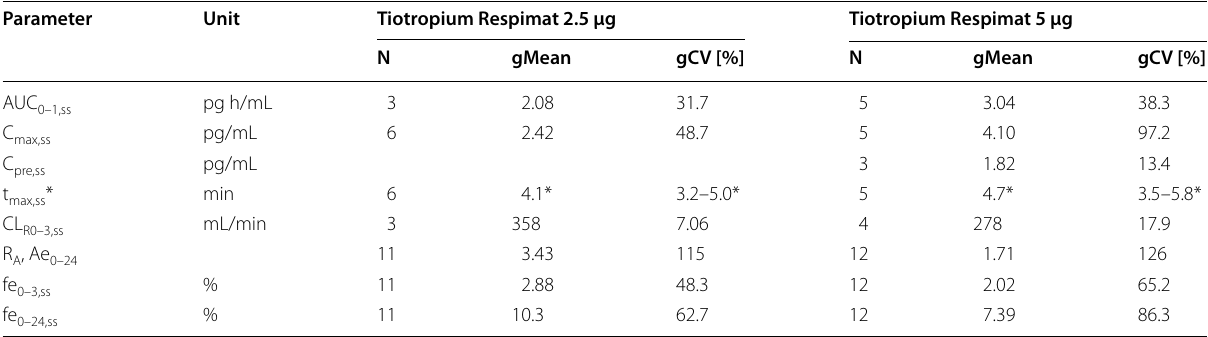
Table 1 PK parameters after multiple dosing of tiotropium delivered by the Respimat ® inhaler in children